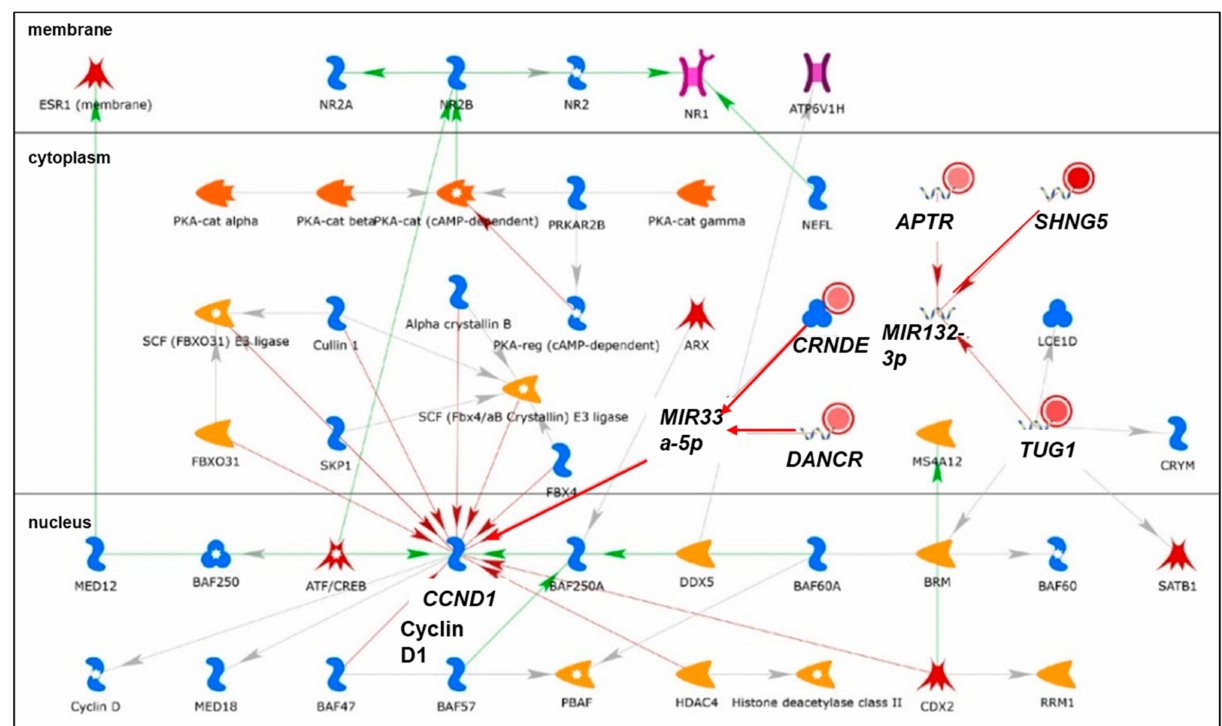
Figure 2. Network 2: TUG1, CRNDE, APTR, DANCR, and SNHG5 , identified in lncRNAs downregulated by miR-29b-1-3p and miR-29a-3p in MCF-7 and/or LCC9 cells by MetaCore analysis. Green lines with arrows = stimulation; red lines with arrows = inhibition.